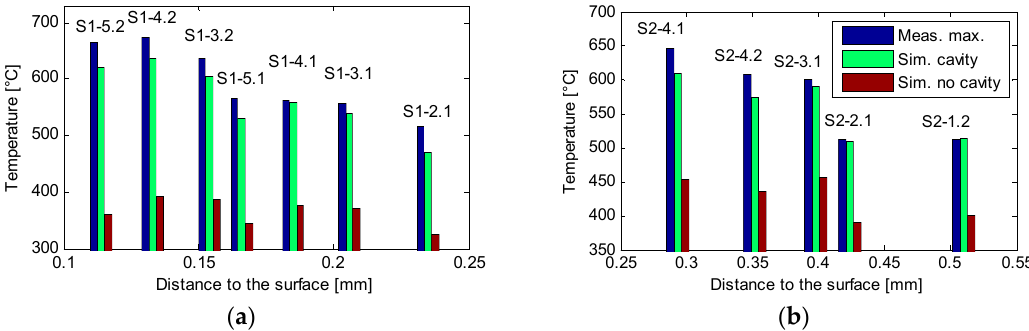
Figure 7. Maximum measured and simulated temperatures in the cavity in condition set S1 ( a ) and in S2 ( b ).